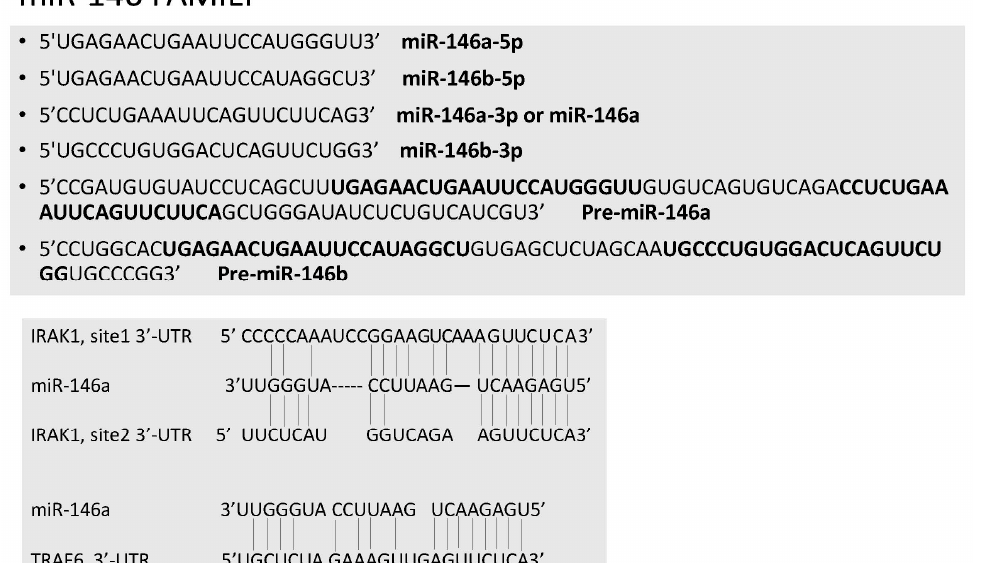
Non ‐ Coding RNA 2017 , 3 , 22 Figure 3. miR ‐ 146 family. Top panel: Sequence of pre ‐ miR ‐ 146a and pre ‐ miR ‐ 146b, mature Figure 3. miR-146 family. Top panel: Sequence of pre-miR-146a and pre-miR-146b, mature miR-146a-5p, miR ‐ 146a ‐ 5p, miR ‐ 146b ‐ 5p, miR ‐ 146a ‐ 3p and miR ‐ 146b ‐ 3p. Bold letters correspond to the sequence of miR-146b-5p, miR-146a-3p and miR-146b-3p. Bold letters correspond to the sequence of mature miRs. mature miRs. Bottom panel: Molecular targets of 146a: IRAK1 and TRAF6. Bottom panel: Molecular targets of 146a: IRAK1 and TRAF6.